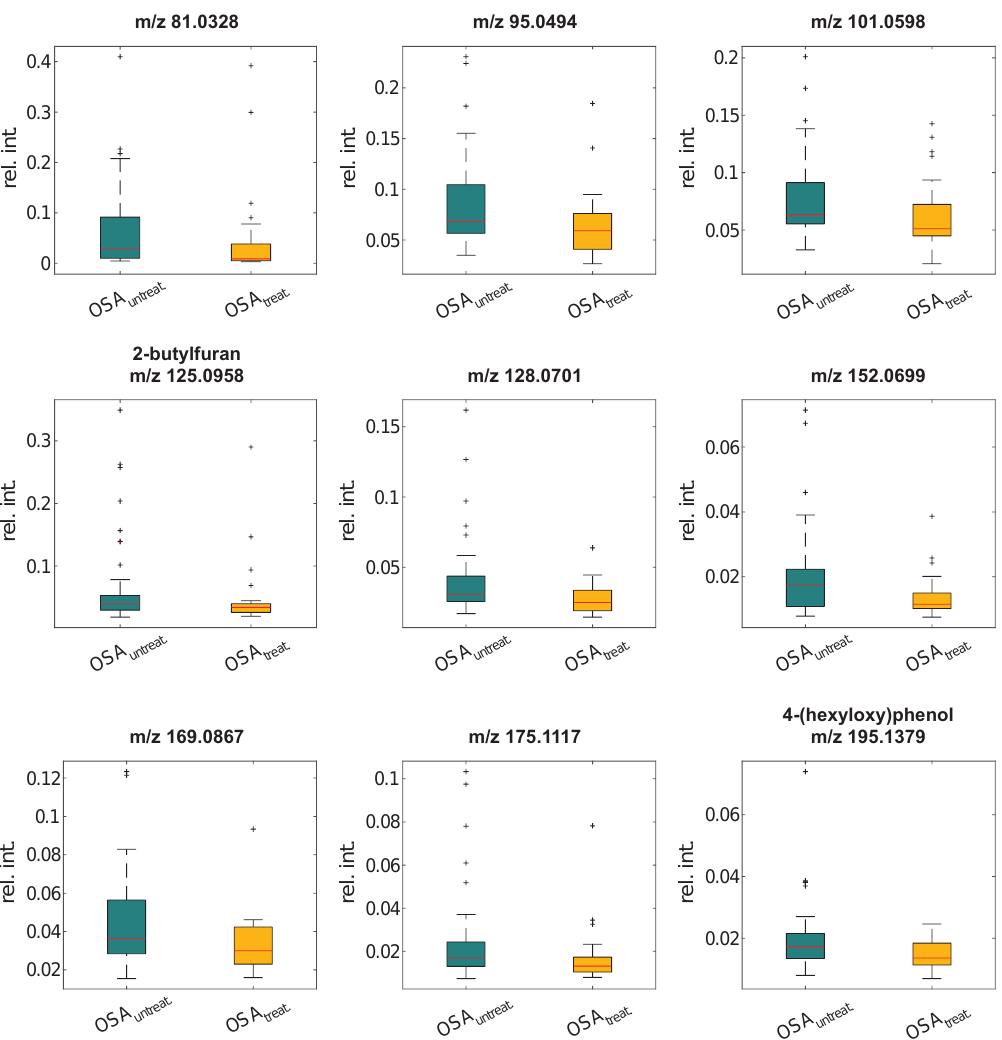
OSA patients (Table 2).